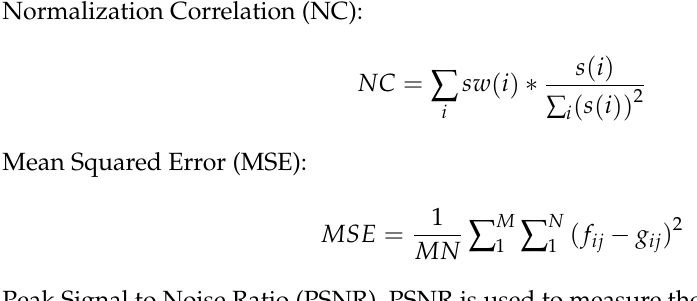
Figure 12. Average execution time to all.